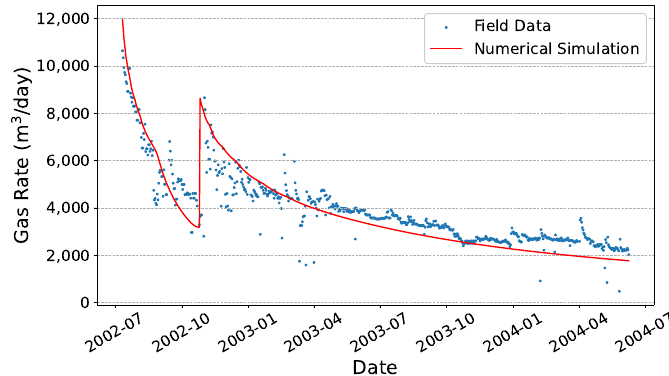
Figure 5. History match of CH 4 production rate during primary CBM